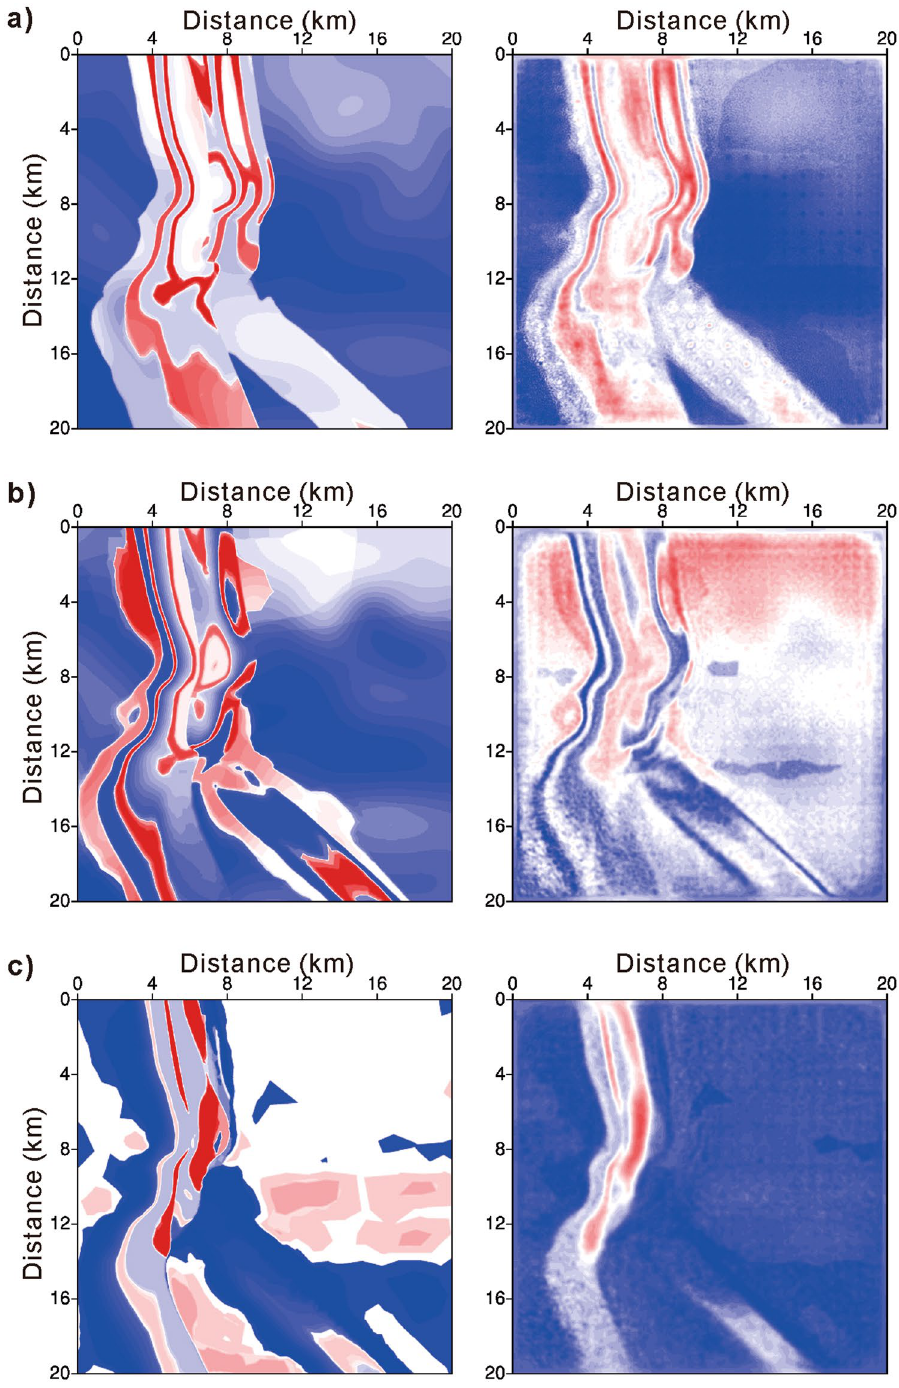
Figure 6. Shot-encoded FWI applicability to a 3D model. ( a ) Velocity slices at a depth of 1 km. ( b ) Velocity slices at a depth of 1.5 km. ( c ) Velocity slices at a depth of 2 km. The left column is the true velocity model, and the right column is the velocity model reconstructed using shot-encoded